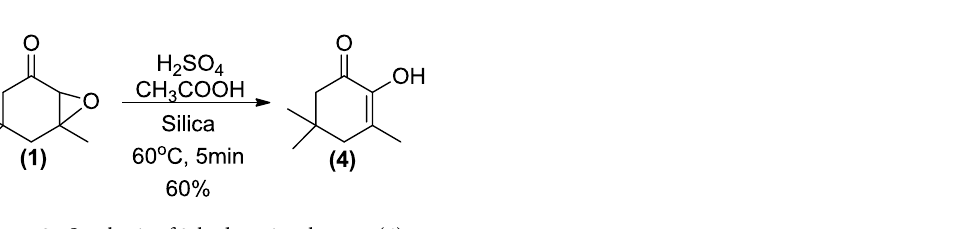
Figure 8. Synthesis of 2-hydroxyisophorone ( 4